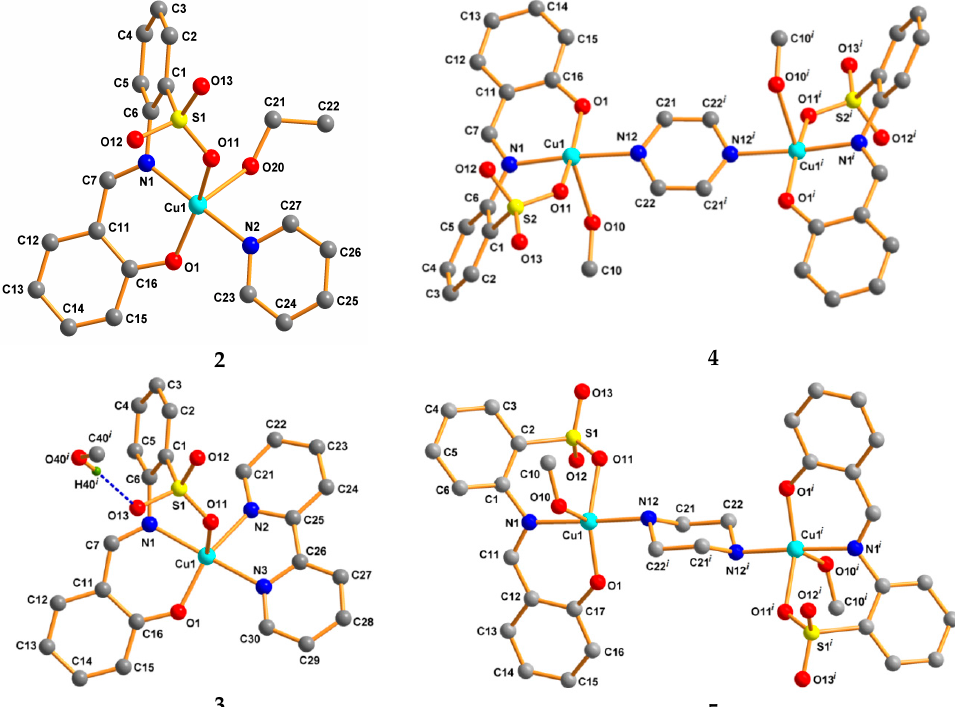
Figure 2. Idealized ball and stick presentation of the crystal structures of 2 – 5 . All H-atoms except those participating in H-bonding are omitted for clarity. Symmetry: x, y, − 1+z (in 3 ), 1 − x, − y, 1 − z (in 4 ), and 2 − x, − y, − z (in 5 ).